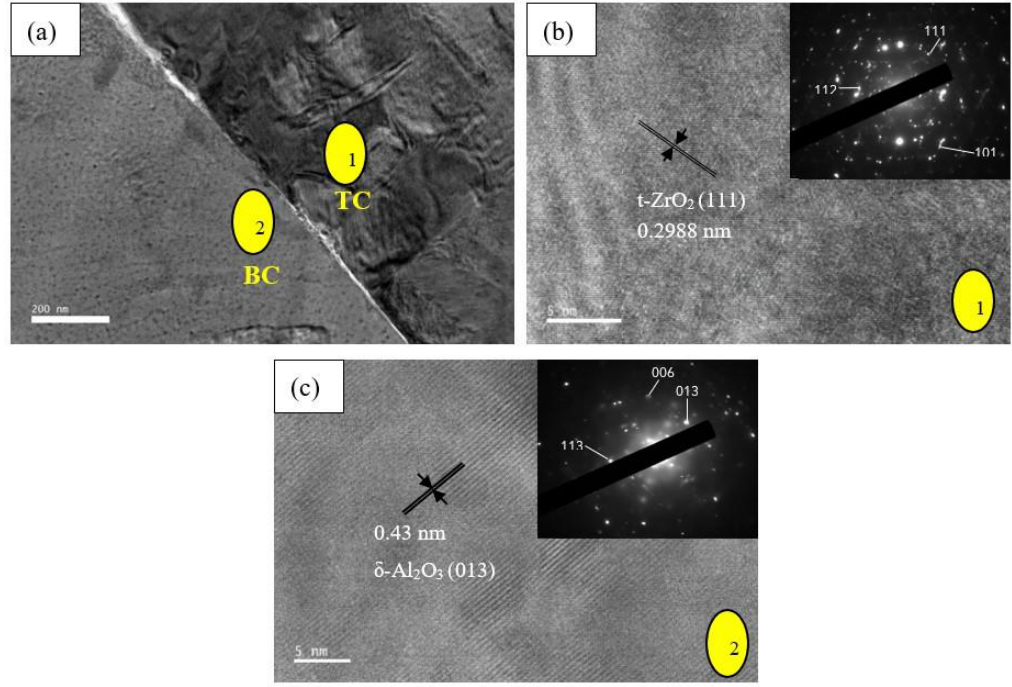
Figure 6. TEM micrograph of ( a ) TGO cross-sectional of sample A with interplanar distance and diffraction patterns at ( b ) topcoat, and ( c ) bondcoat.